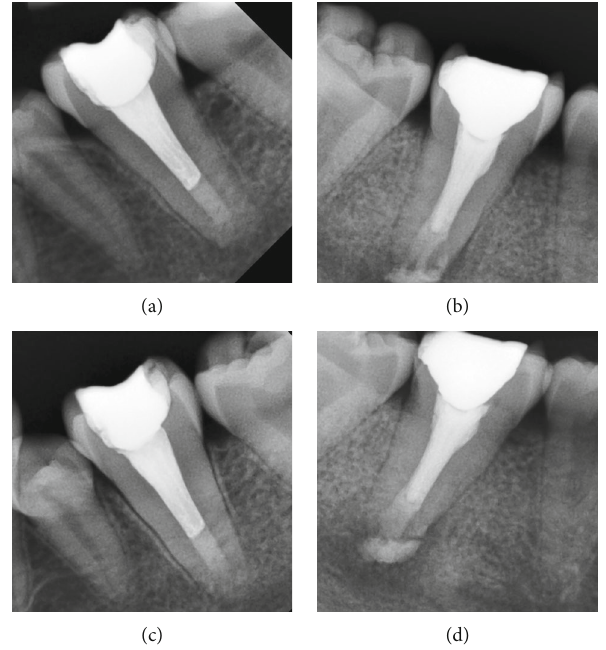
Figure 5: (a, b) Postobturation radiograph #36 and #46. (c, d) One-year follow-up radiograph #36 and #46. Table 1: Case reports of mandibular fi rst molars showing single